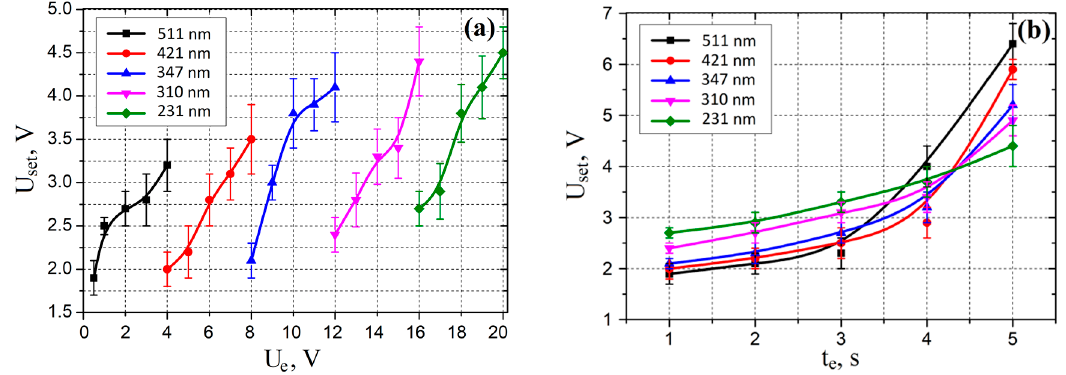
Figure 10. Experimental investigations of set voltage dependences on electroforming voltage ( a ) and electroforming time ( b ) at various grain diameters.